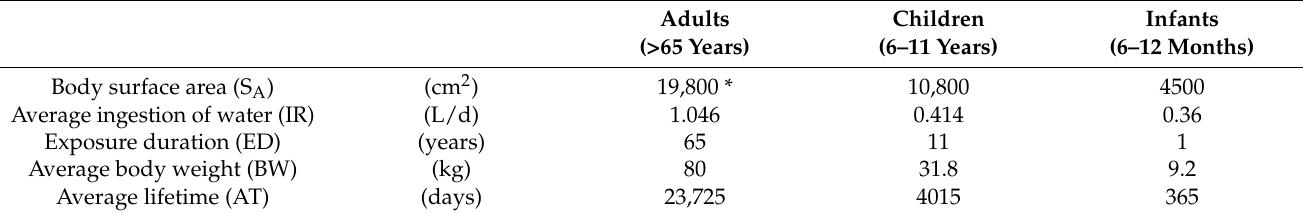
Table 1. Input data is used to calculate noncarcinogenic human health risk due to anions, metals, and toxic elements exposure through dermal contact and water ingestion